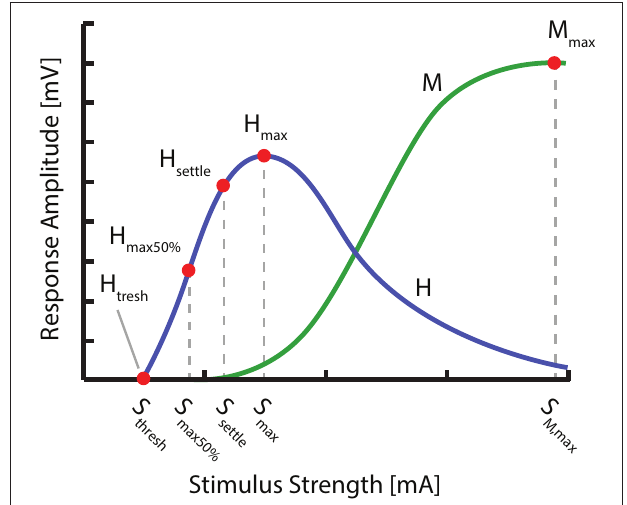
FIGURE 2 | Overview of the distinct points measured within the H- and M- Wave recruitment curves: H-Reflex threshold ( H thresh ), 50% of H-reflex maximum ( H max 50 % ), the point at which the ascending part of the recruitment curve begins to settle ( H settle ), the maximum H wave ( H max ) as well as the maximum M-wave ( M max